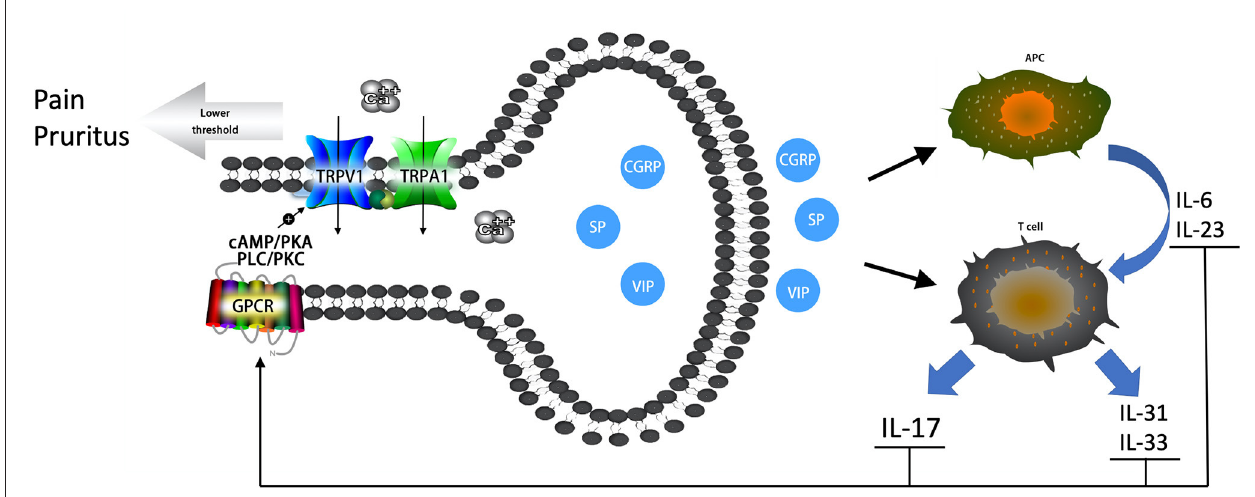
FIGURE 1 | The vicious circular pathway between nociceptive neurons and Th17 immune responses in psoriatic lesions. Neuropeptides (CGRP, SP, VIP) prompt the release of IL-6 and IL-23 and bias antigen presentation for Th17 cell responses. Neuropeptides also prompt Th cells to release IL-17, IL-31, and IL-33. Increased cytokines can sensitize TRPV1 and TRPA1 channels through GPCRs via secondary messenger-signaling pathways, the cAMP/PKA and PLC/PKC pathways, following Ca 2 + elevation. An elevated Ca 2 + concentrate prompts the release of neuropeptides, which forms a vicious circle pathway between nociceptive neurons and the local immune system. Sensitized TRPV1 and TRPA1 channels result in pruritus, pain, and hyperalgesia experienced by patients with